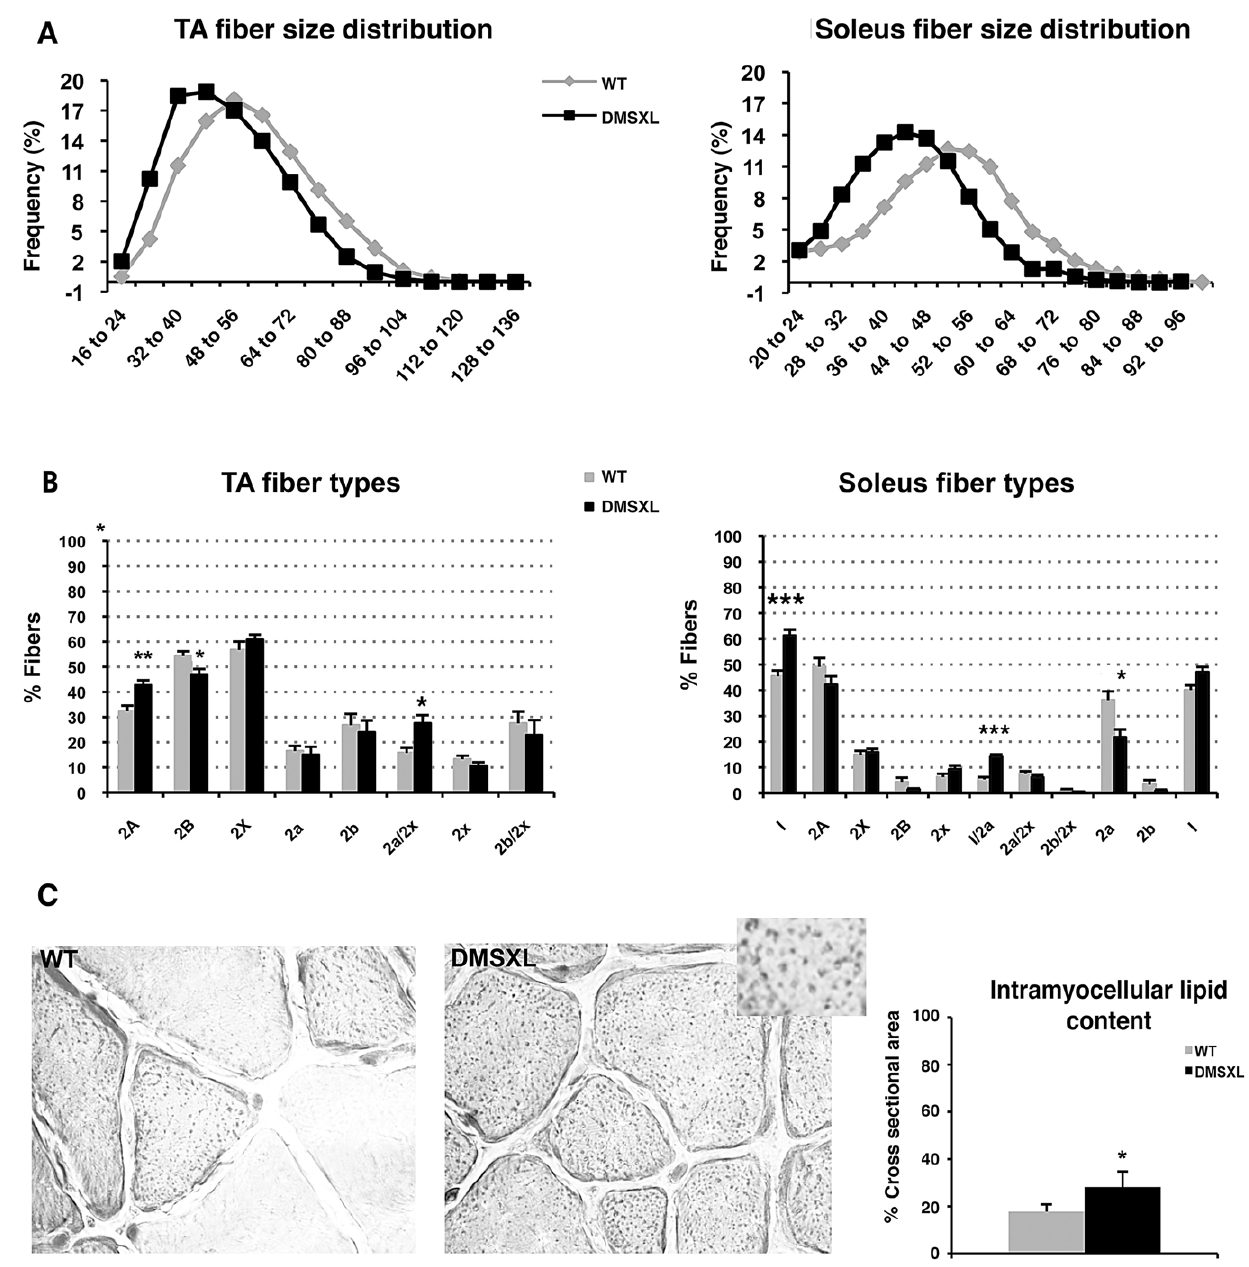
Figure 9. Histological abnormalities in DMSXL muscles. (A) Fiber size (cross-sectional area, pixels) was measured in tibialis anterior (TA) and soleus muscles from 4-month-old female WT (grey line) and DMSXL (black line) mice, n=3 biological replicates in both groups. (B) Fiber types were determined in TA and soleus muscles from WT (grey histograms) and DMSXL (black histograms) mice, n=3 biological replicates in both groups. (C) Oil Red O staining of muscles section (TA) showed intramyocellular lipid accumulation in DMSXL mice. Data are presented as means 6 SEM (* p , 0.05, ** p , 0.01, *** p , 0.001, Chi-square or Student’s t tests), n=4–5 in both groups.